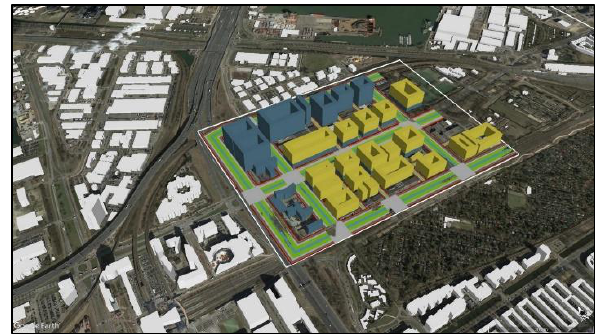
Figure 12. Visualization in CesiumJS of a scenario. Specific attributes can be retrieved by clicking the corresponding building or road element.